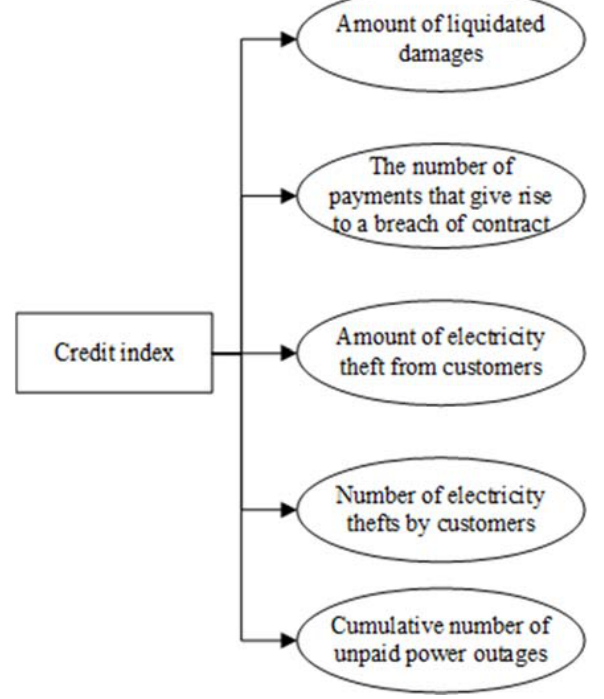
Figure 4. Credit index.